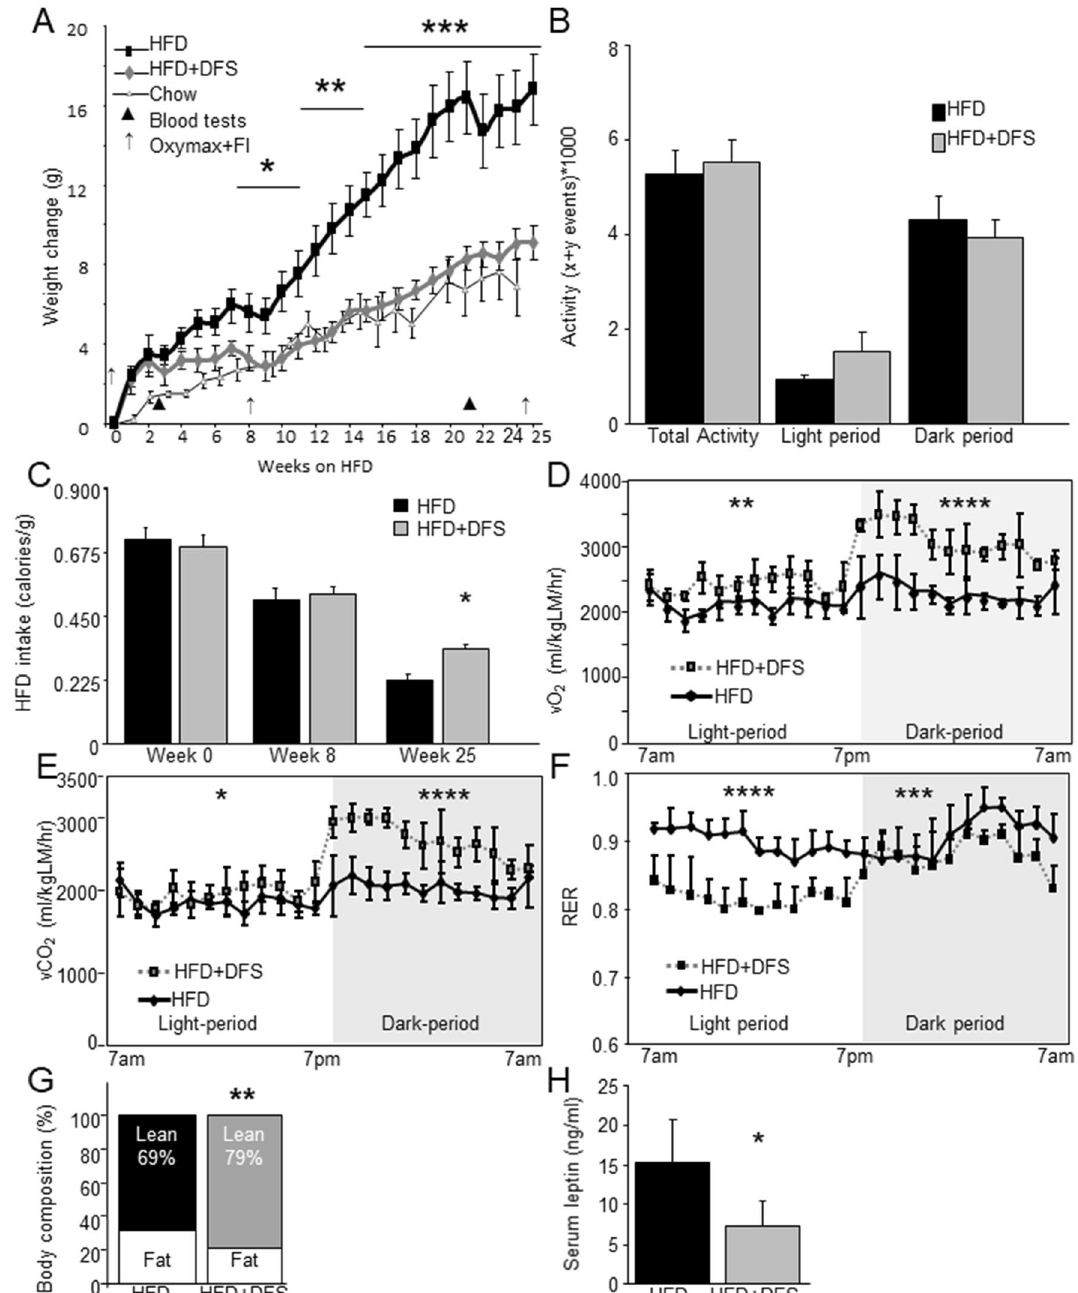
Figure 1. Iron chelation with deferasirox (DFS) prevents high fat diet induced weight gain by increasing energy expenditure. ( A ) Weight gain in mice fed normal chow, high-fat diet (HFD) or HFD + DFS. ( B ) Activity did not differ between HFD and HFD + DFS mice. ( C ) Food intake was similar or higher in mice fed HFD + DFS. ( D ) Oxygen consumption (vO 2 ) was higher in mice eating HFD + DFS. ( E ) Carbon dioxide production (vCO 2 ) was higher in HFD + DFS mice. ( F ) Respiratory exchange ratio (RER) was lower in HFD + DFS mice. ( G ) Lean mass assessed by dual X-Ray absorptiometry (DEXA) was lower in HFD mass, and fat mass was higher. ( H ) Serum leptin was decreased in HFD + DFS mice. *p < 0.05, **p < 0.01, ***p < 0.001, ****p < 0.0001. Data is shown as mean ± SEM (standard error of the mean) unless otherwise